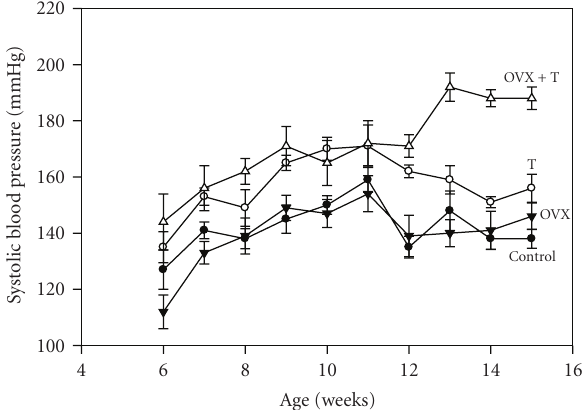
Figure 2: Urinary sodium excretion (24hr) by age and treatment (means ± SEM). Two-way repeated measures ANOVA: treatment- F = 9 . 1, df = 3, P < . 001, age- F = 3 . 1, df = 9, P < . 05, interaction not significant. Open bars: controls (C, n = 8), solid black bars: ovarectomy (OVX, n = 6), gray bars: testosterone treated (T, n = 6), striped bars: ovarectomy and testosterone treatment (OVX+T, n = 7) ( ∗ P < . 05, ∗∗ P < . 01, ∗∗∗ P < . 001 compared to control).